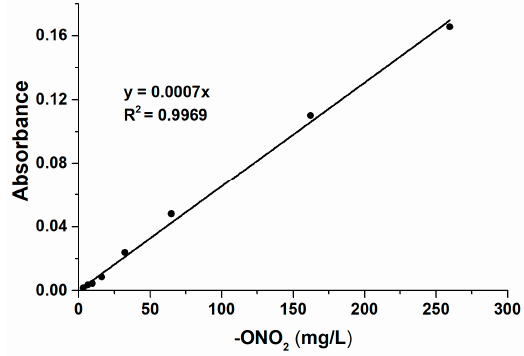
Figure 7. Standard curve of ISMN.